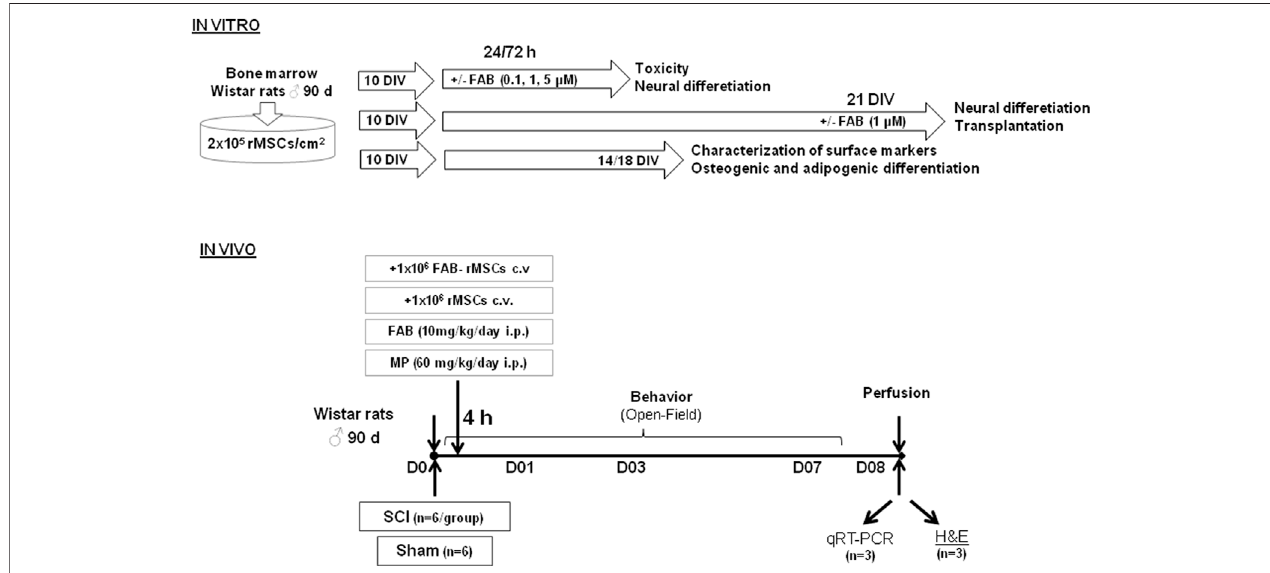
FIGURE 1 | Experimental design showing model adopted to investigate effects of rat bone marrow mesenchymal stem cells (rMSCs) and agathis fl avone (FAB) treatments in a model of spinal cord injury (SCI). Days in vitro (DIV).